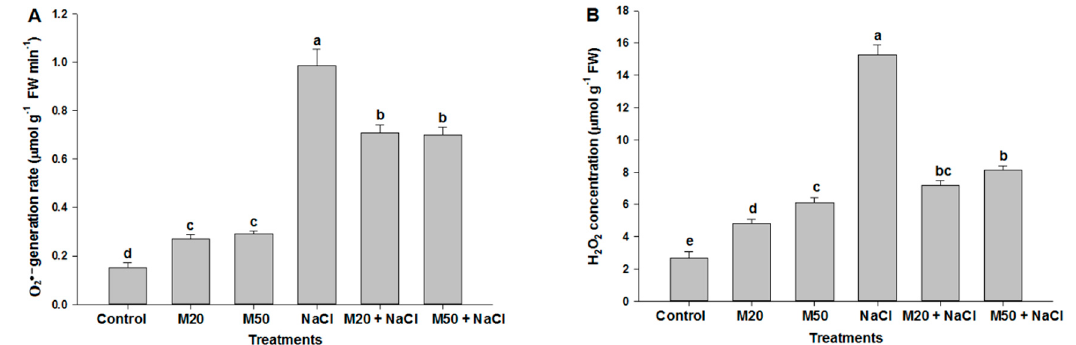
Figure 5. Effect of melatonin on ( A ) O 2• − content, and ( B ) H 2 O 2 content in leaves of tomato seedlings under salinity. Data represent mean of 4 replicates with bars indicating SE. The bars labelled with different letters are significantly different at p < 0.05% . [DDW (control), 20 μ M melatonin (20M), 50 μ M melatonin (50M), 100 mM NaCl (NaCl)].